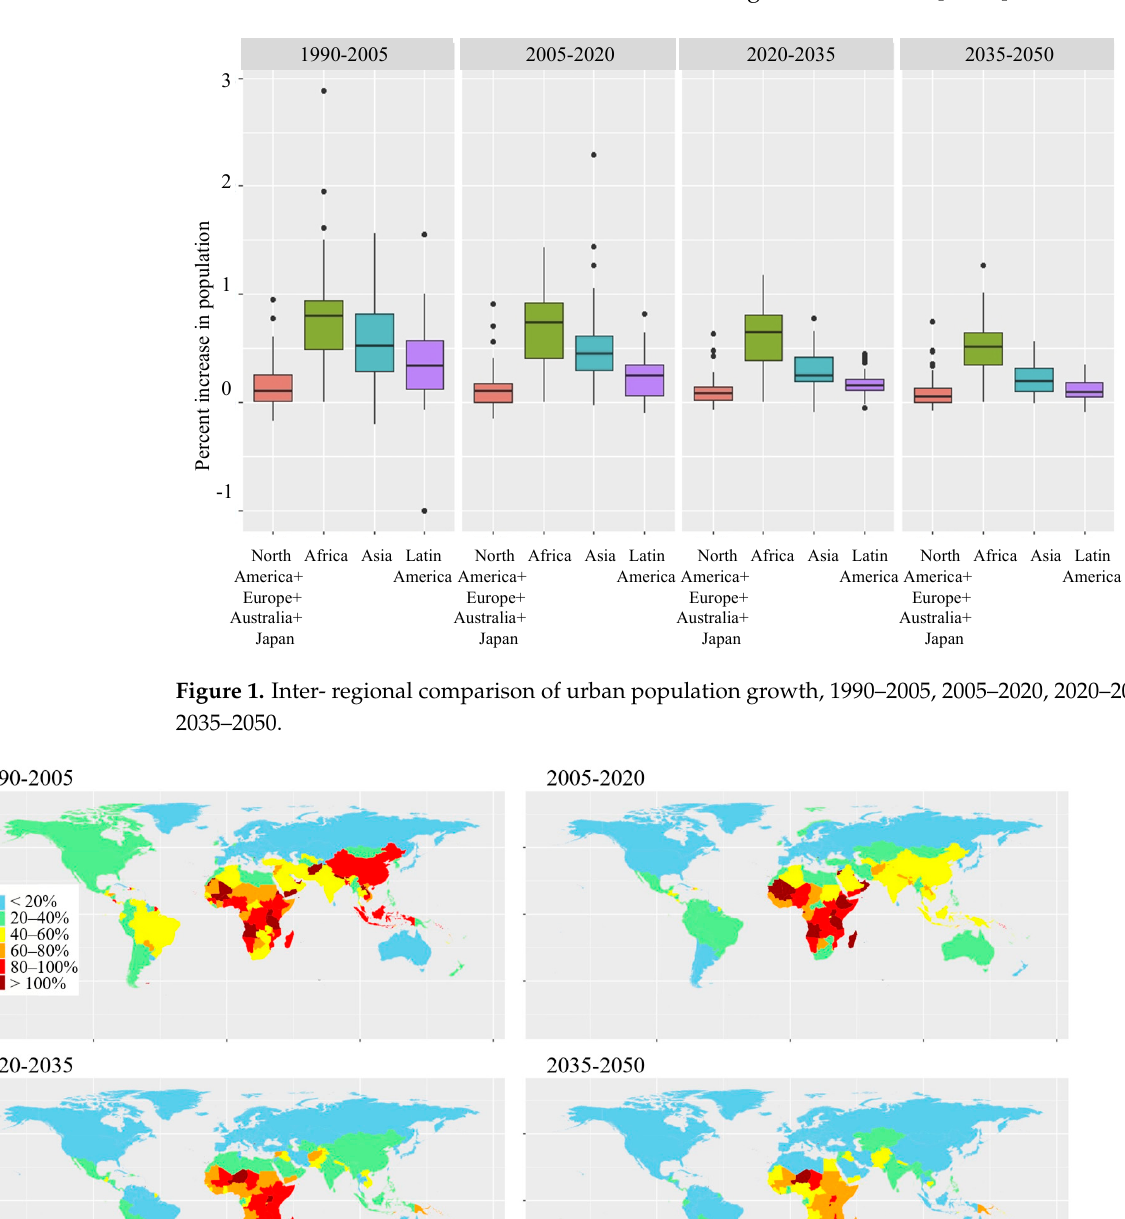
Figure 2. Global urban population growth, ( a ) 1990–2005, ( b ) 2005–2020, ( c ) 2020–2035, ( d ) 2035– 2050 .